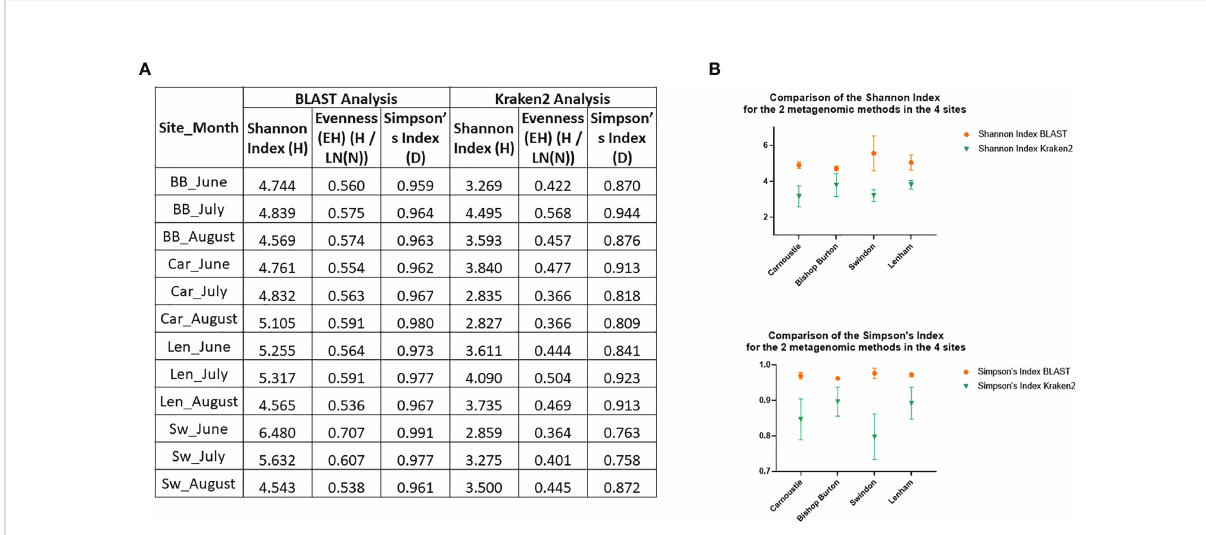
FIGURE 6 Comparison of the two metagenomic methods, BLAST and Kraken2. (A) Table with the monthly values for all the sites of Shannon – Wiener diversity index, its Evenness, and the Simpson ’ s Index for both methods. Car, Carnoustie; BB, Bishop Burton; SW, Swindon; Len, Lenham; (B) XY Plots of variances for the Indexes values between the two methods (BLAST in Orange; Kraken2 in Green) by